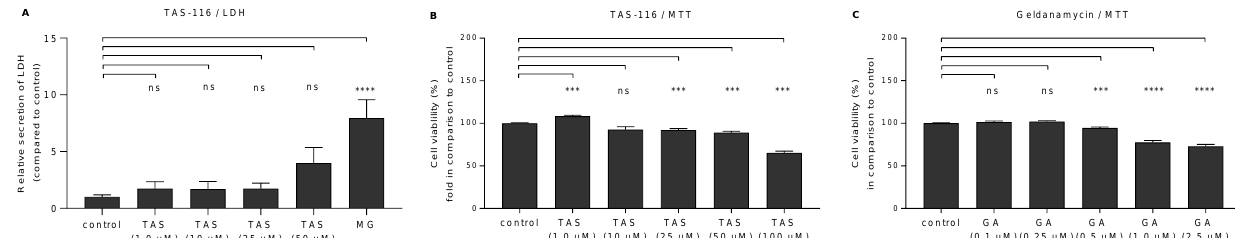
Figure 1. Cell viability upon exposure of ARPE-19 cells to TAS-116 or geldanamycin. Cells were treated for 48 h with the indicated TAS-116 (TAS) or geldanamycin (GA) concentrations. LDH release from TAS-treated cells was measured from cell culture medium samples and compared to the values of untreated control cells, which were set to a value of 1 ( A ). Cells exposed to MG-132 (MG) served as a positive control. MTT results of TAS-116 ( B ) or geldanamycin-treated cells ( C ) were compared to untreated control cells, the viability of which was set to 100%. Data are combined from two ( B ) or three ( A , C ) independent experiments with four parallel samples in each group. All results are presented as mean ± SEM. *** p < 0.001, **** p < 0.0001, ns = nonsignificant, Mann–Whitney U test.